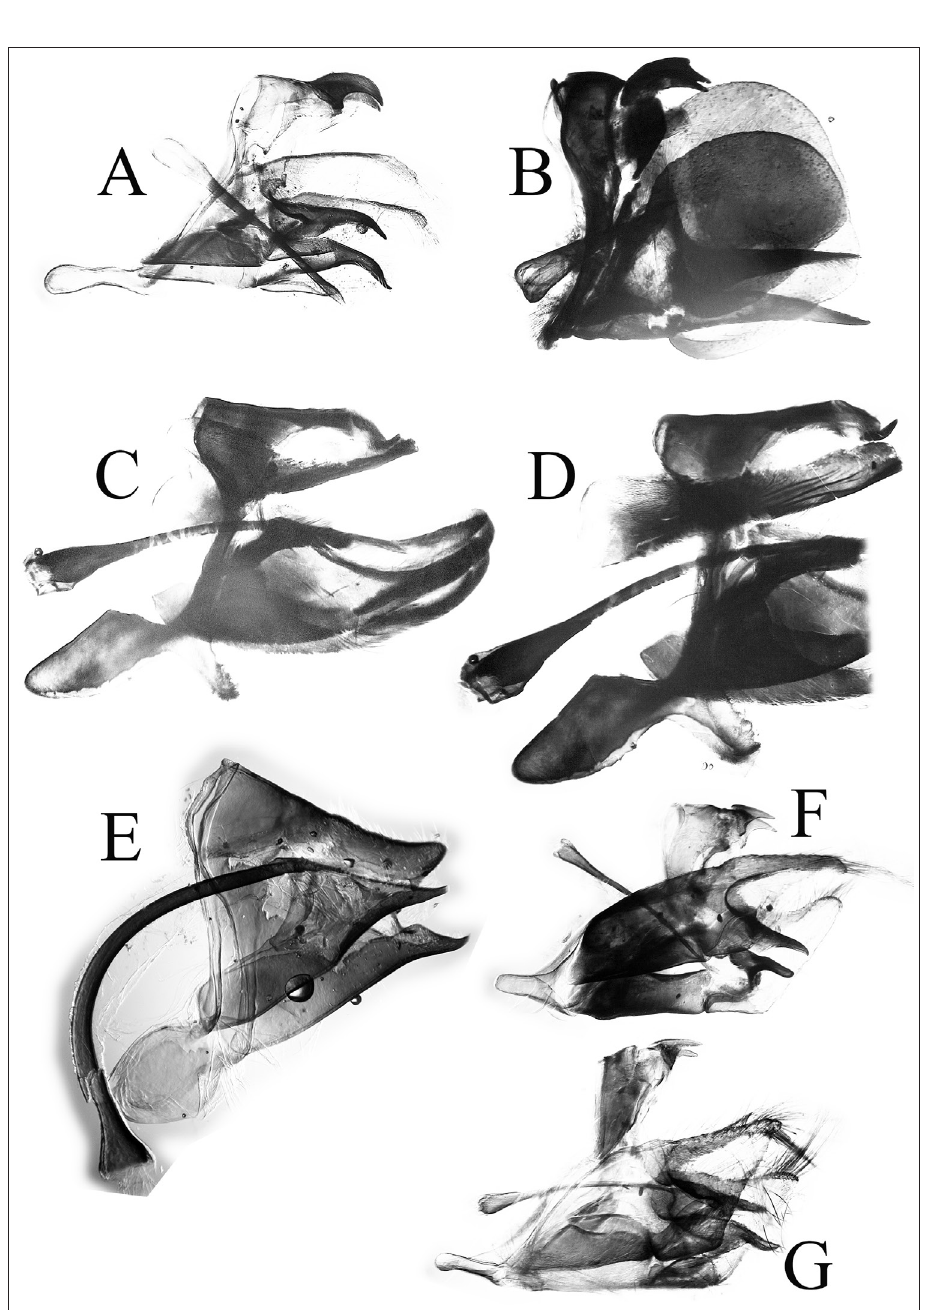
Figure 3. Male genitalia of Parnassiinae. A – Koramius ( Kailasius ) autocrator , Tajikistan, Sarezskoe Lake; B – Lingamius szechenyii (Frivaldsky, 1886), China, Qinhai near Tsa-Ka; C, D – Sachaia tenedius (Eversmann, 1851), Russia, Transbaikal, Mondy (in C subscaphius removed); E – Kreizbergius simonius (Staudinger, 1889), lectotype; F – Koramius ( Koramius ) staudingeri (Bang-Haas, 1882), lectotype; G – K. stoliczkanus (C. & R. Felder, 1865),